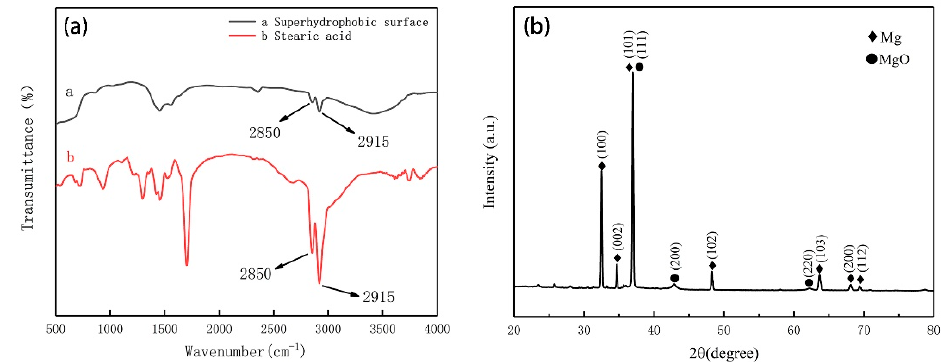
Figure 4. ( a ) FT-IR infrared spectra of the superhydrophobic magnesium alloy (SMA) surface and stearic acid, and ( b ) XRD diffraction patterns.